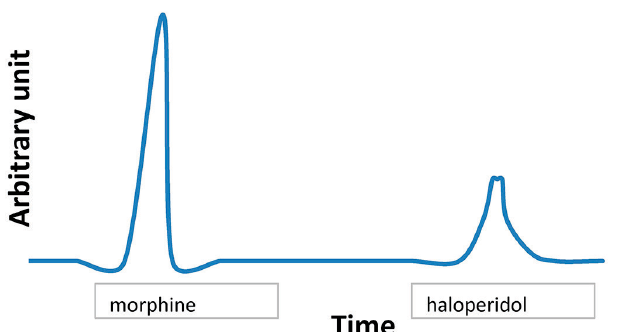
FIGURE 1 - Chromatogram of the admixture morphine-